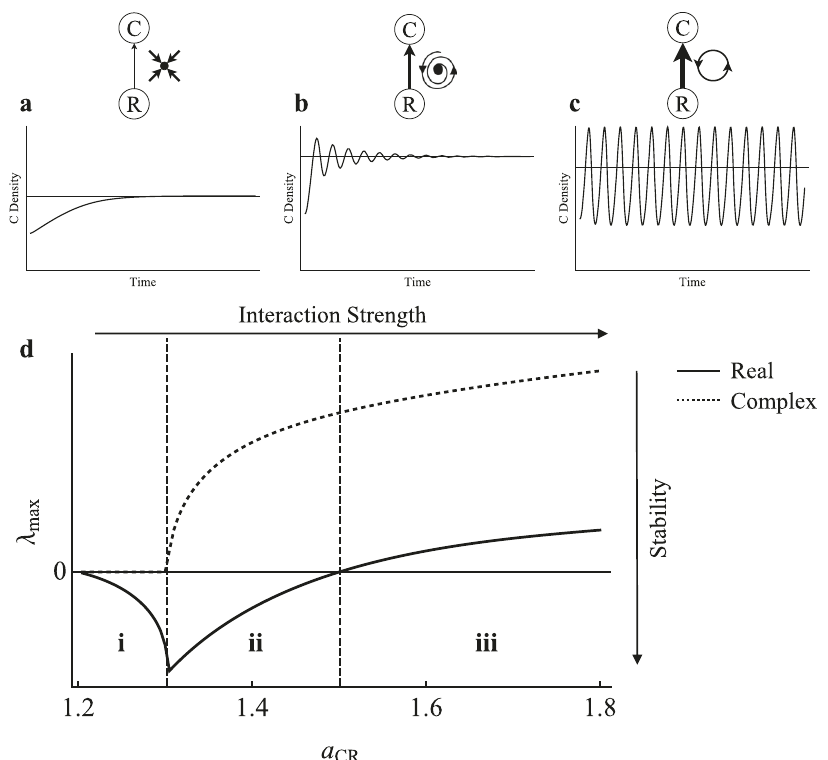
Fig. 2 C – R checkmark stability response. d Local stability (real and complex parts of the dominant eigenvalue; λ max ) as a function of interaction strength ( a CR ) for the Rosenzweig – MacArthur C – R module. Time series re fl ect dynamics associated with region i , ii , and iii , respectively, following a perturbation that removes 50% of consumer biomass: a Stable equilibrium; monotonic dynamics. b Stable equilibrium; overshoot dynamics. c Unstable equilibrium; limit cycle. Boldness of arrows indicates the strength of interaction ( a CR ).